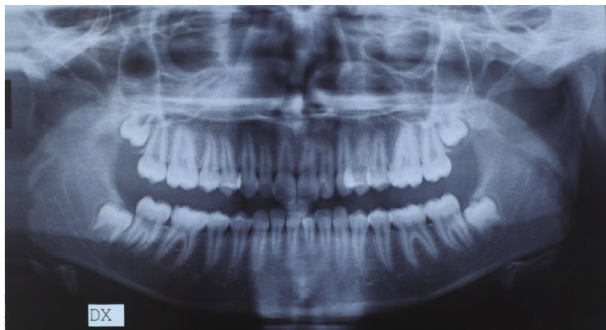
Figure 6: Initial